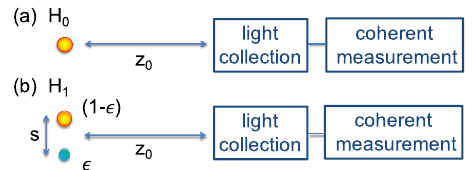
Fig. 1 | An optical imaging system is used to discern between two hypotheses, followedbyparameterestimation. Ifhypothesis H 0 istrue( a ),onlyonesourceof intensity N ispresent;if H 1 istrue( b ),twosourcesarepresent,withtotalintensity N and the relative intensity is ϵ /(1 − ϵ ). For H 1 , angular separation between the two sources is θ = s / z 0